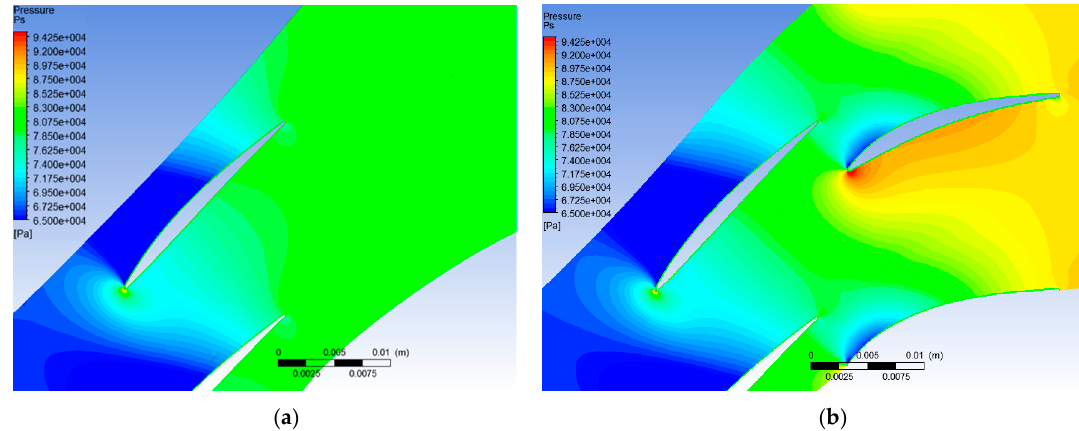
Figure 9. Comparison of static pressure contours in single-blade and tandem configurations; incidence − 1°, inflow Mach number 0.8. ( a ) FB single-blade configuration; ( b ) tandem configuration.